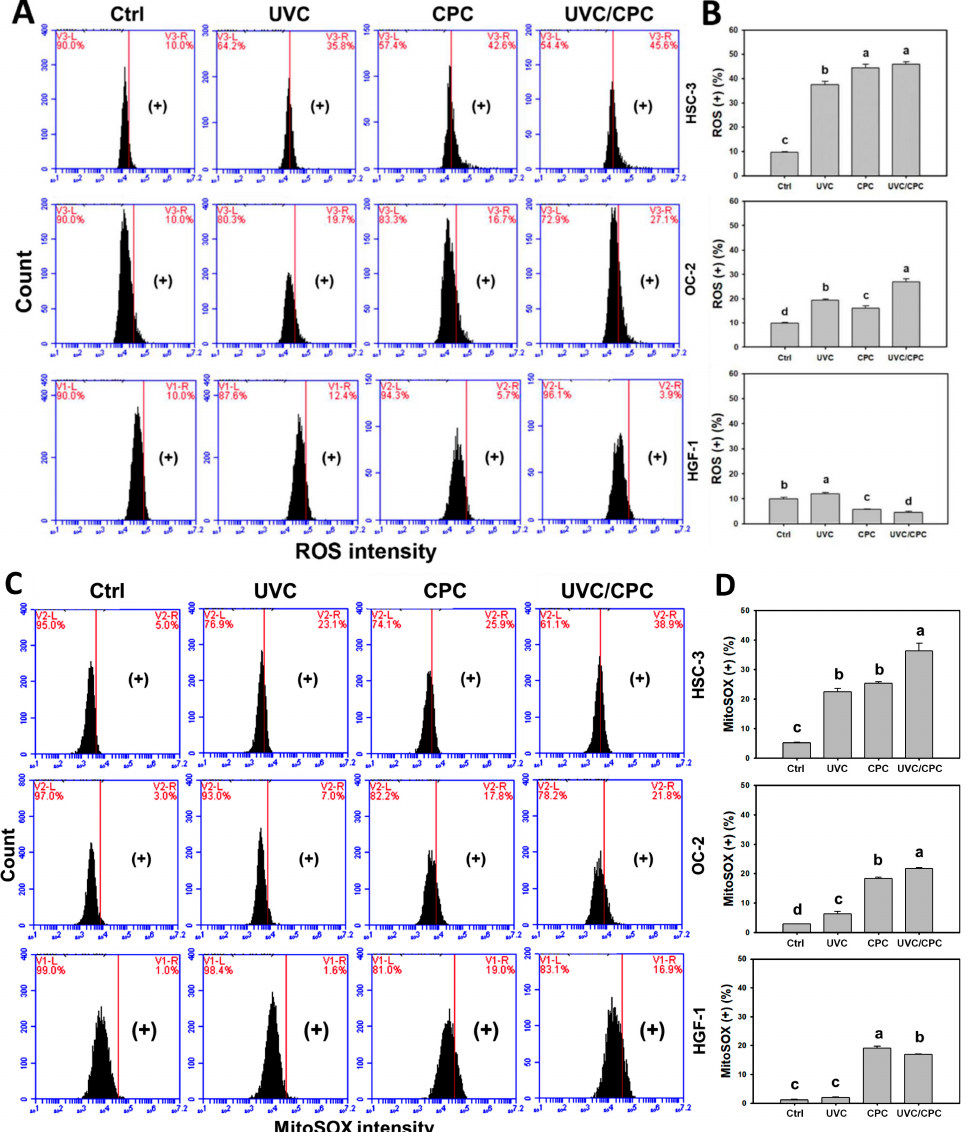
Figure 2. ROS and MitoSOX changes of oral cancer and normal oral cells following UVC and/or CPC treatments. Oral cancer (HSC-3 and OC-2) and oral normal (HGF-1) cells were arranged to treat with vehicle control, UVC (10 J/m 2 ), CPC (5 µ g/mL), and UVC/CPC (10 J/m 2 and 5 µ g/mL). Flow cytometry was performed after 24 h treatment. ROS (+) and MitoSOX (+) populations were labeled with (+), i.e., high intensity. ( A ) ROS patterns. ( B ) Statistics for ( A ). ( C ) MitoSOX patterns. ( D ) Statistics for ( C ). Data, mean ± SD ( n = 3). Based on multiple comparisons after Tukey’s HSD Test, different tests labeled with different top letters differ significantly ( p < 0.05). In the example of ( D ) MitoSOX in HSC-3 cells, UVC and CPC showing “b, b” indicated a non-significant difference between each other. UVC/CPC and CPC in HSC-3 cells showing “a, b” indicated a significant difference between each